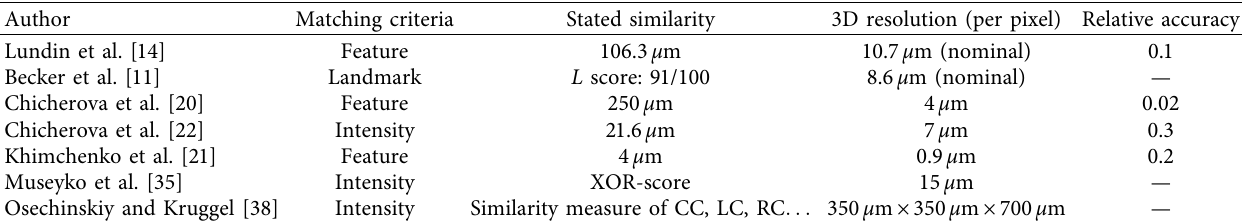
Table 1: Quantitative comparison of diferent slice-to-volume registration approaches through the calculation of the relative accuracy.